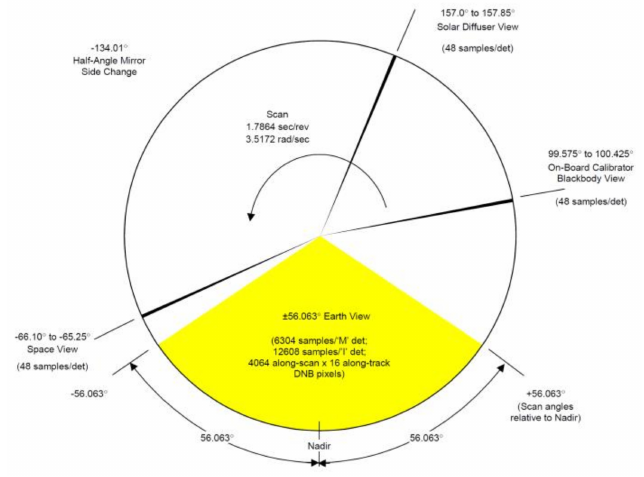
Figure 1. VIIRS scan section diagram illustrating the different collection regions and their angles during a single scan.